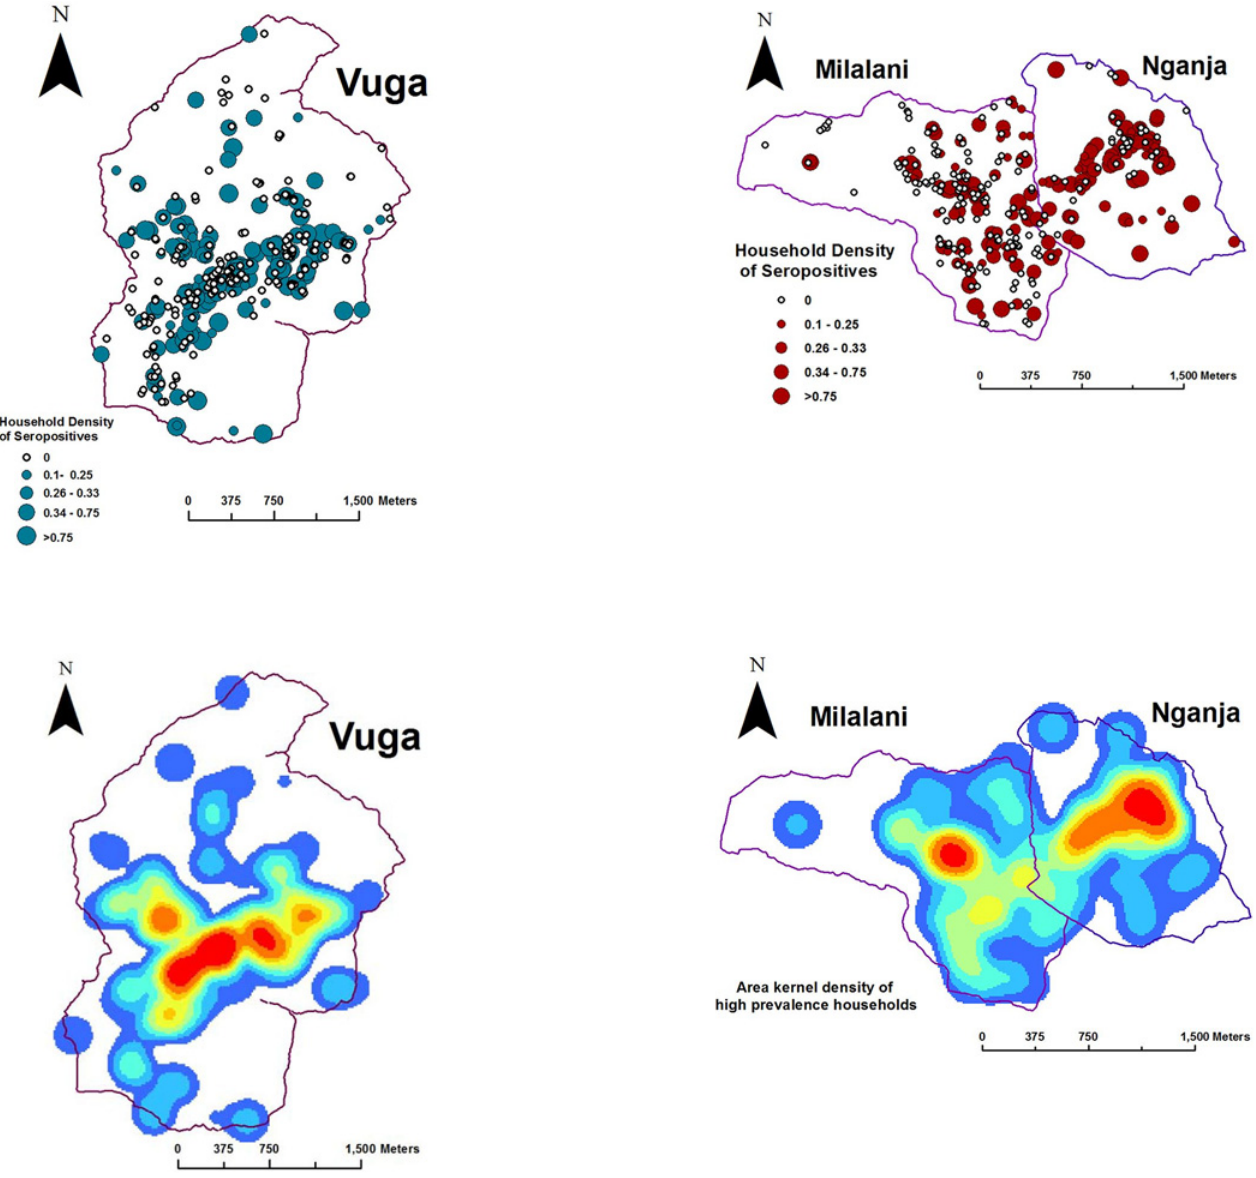
Figure 4. Analytic maps of alphavirus seropositivity in Milalani-Nganja (right) and Vuga (left). The top panels show household locations as dots proportional to the household density of seropositives; the bottom panels show the kernel density estimates for alphaviral seropositivity as a color range, with red having the highest vales and blue the lowest